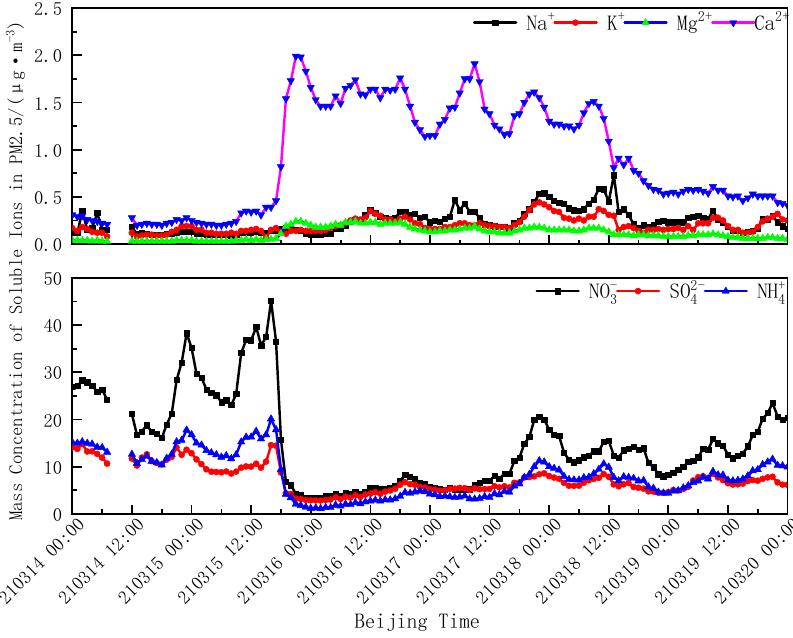
Figure 12. Mass concentration of water-soluble ions in PM2.5.